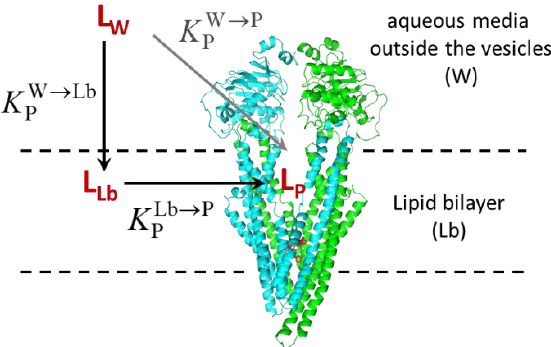
Figure 9. Orientation of P–gp in the inside-out vesicles of native membranes obtained from the High-Five insect cells, with the definition of the distinct environments: aqueous media (W), lipid bilayer (Lb), and P – gp (P). The partition coefficients between the distinct media are also indicated.